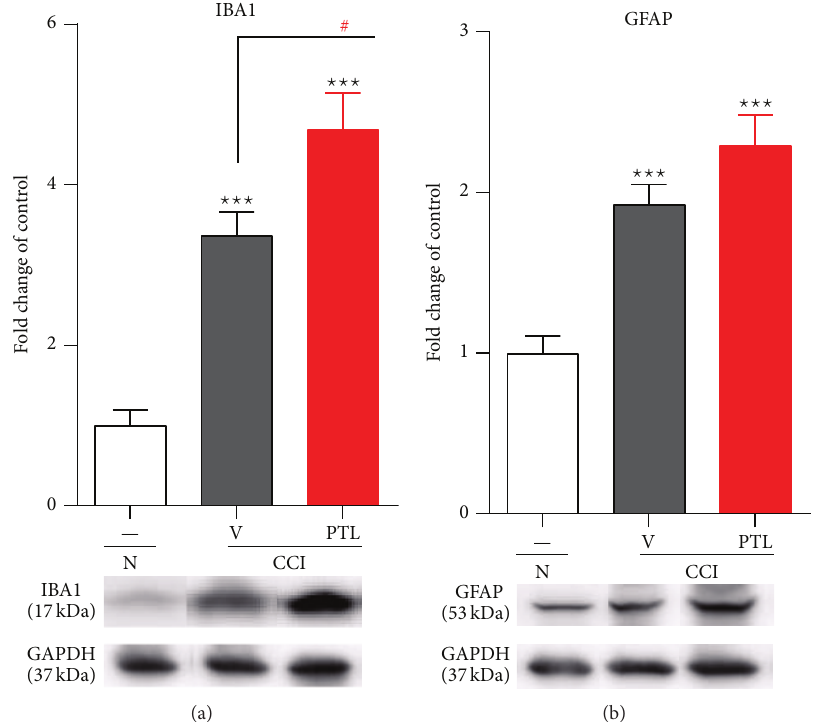
Figure 2: Repeated PTL administration influenced microglia/macrophage activation in the spinal cord level under neuropathic pain. Seven days after CCI in the ipsilateral dorsal spinal cord the protein level for IBA1 (a) and GFAP (b) were upregulated due to nerve injury. Repeated PTL administration increased the level of IBA1 (a), but the GFAP protein level was unchanged (b). The Western blot data are presented as the mean ± SEM and represent the normalized averages derived from analyses of 5–7 samples for each group. Intergroup differences were analyzed using ANOVA followed by Bonferroni’s multiple comparison test. ∗∗∗ 𝑃 < 0.001 indicate significant differences compared to na¨ıve rats. # 𝑃 < 0.05 indicate significant differences between vehicle-treated and PTL-treated CCI-exposed rats. N-na¨ıve, V-vehicle, and PTL- parthenolide. The immunoblots shown are representative of 5–7 individual